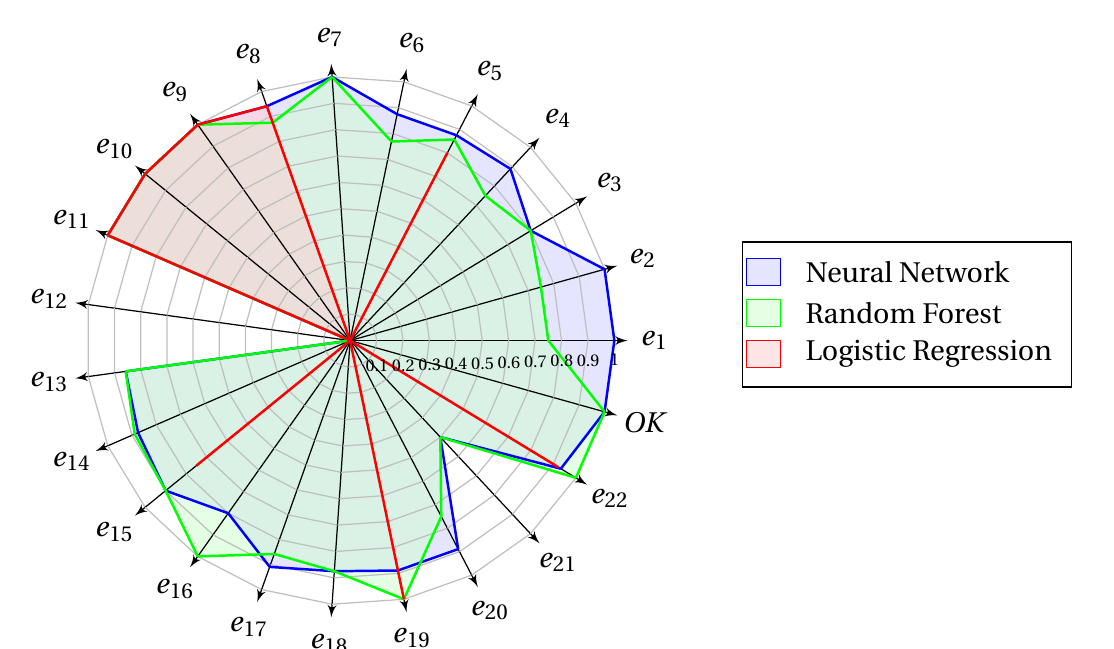
Figure 14. Comparison of the results of 3 applied methods machine learning in terms of precision.